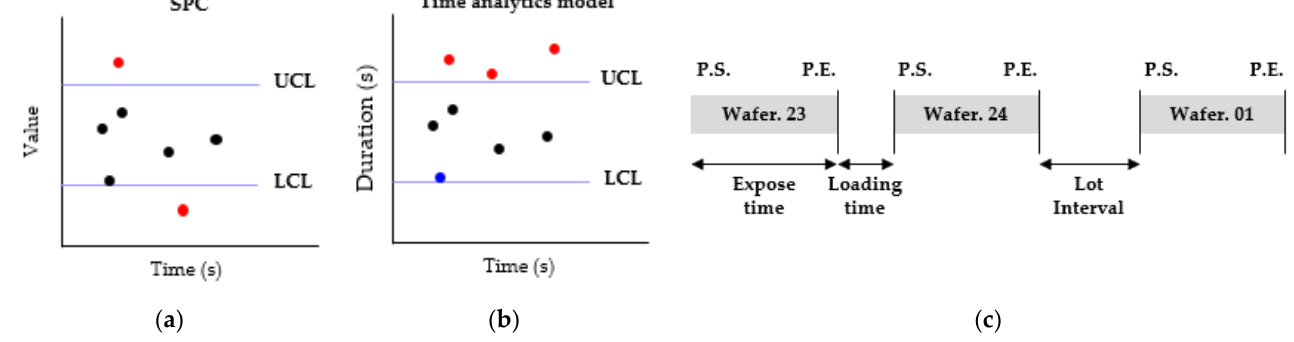
Figure 1. ( a ) Shows the general SPC trend. Red dots represent the outside of control range. ( b ) Shows the loading time of each wafer in the control chart. A blue dot is the maximum ability of the equipment, and it cannot be placed under LCL. ( c ) Shows the classification of process time. (P.S.: Process Start, P.E.: Process